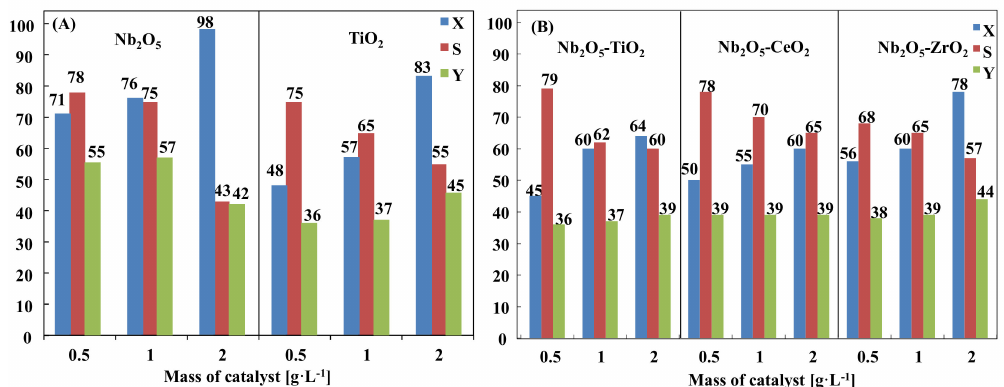
Figure 10. Fructose conversion ( X ), selectivity to HMF ( S ) and yield ( Y ) obtained in catalytic experiments carried out with an initial fructose concentration of 1 M at 165 ◦ C for 3 h in the presence of 6 mL of a suspension of ( A ) Nb 2 O 5 or TiO 2 or ( B ) the composites as heterogeneous